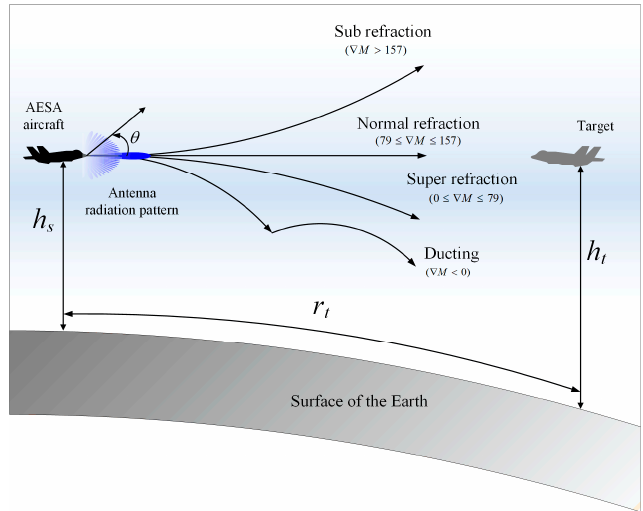
Figure 1. Four refractive conditions of the wave propagation of an air-to-air airborne radar with the gradient of the modified refractivity M according to the height.